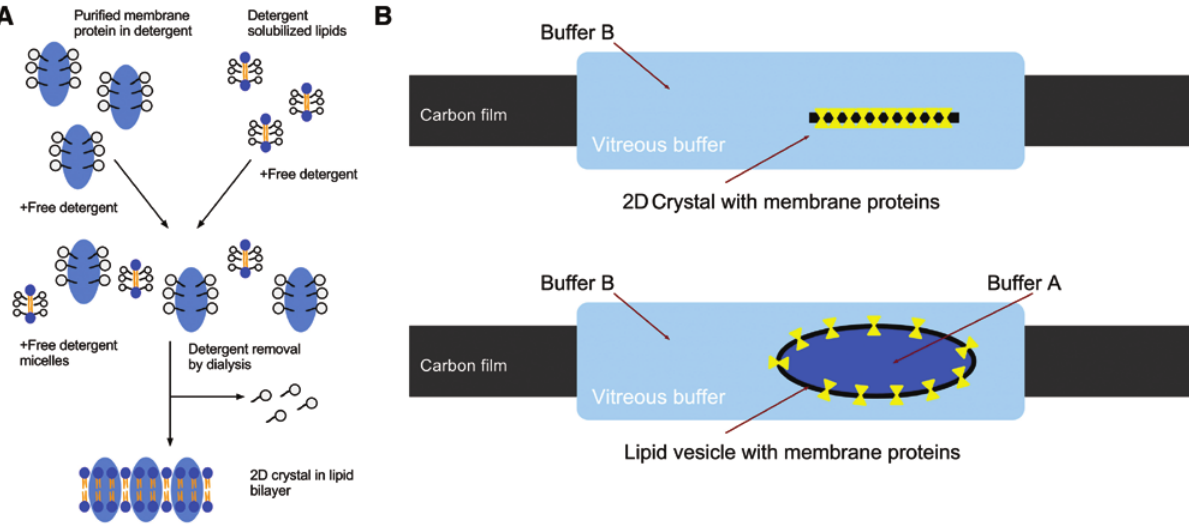
Figure 2: Reconstitution of membrane proteins in a lipid bilayer and vitrification for cryo-EM. (A) The principle of 2D crystallization: detergent-solubilized and purified membrane proteins are mixed with detergent-solubilized lipids, and the detergent is removed to form 2D crystals. (B) Vitrification of planar 2D crystals (above) and proteoliposomes with 2D crystals in their bilayer (below). The